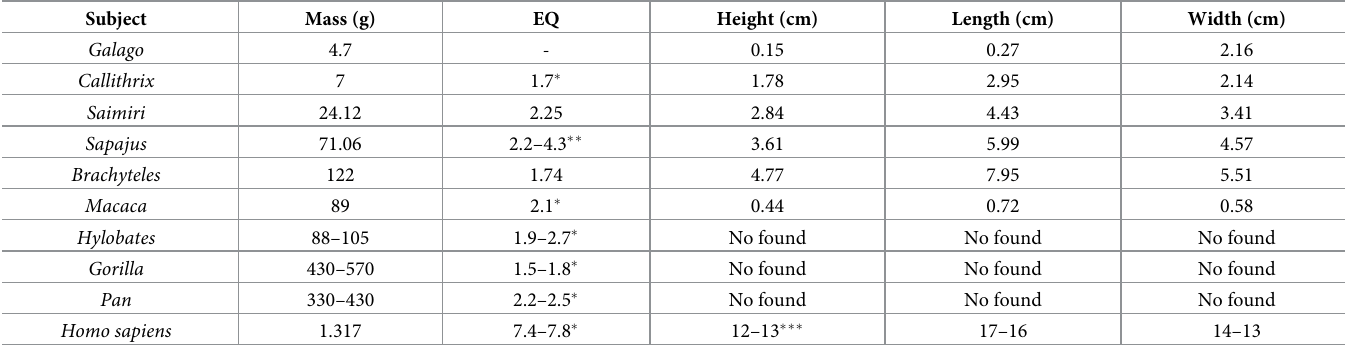
Table 8. Encephalon mass, height, length, width, and Encephalization Quotient (EQ) of primate species studied in the present study and previous